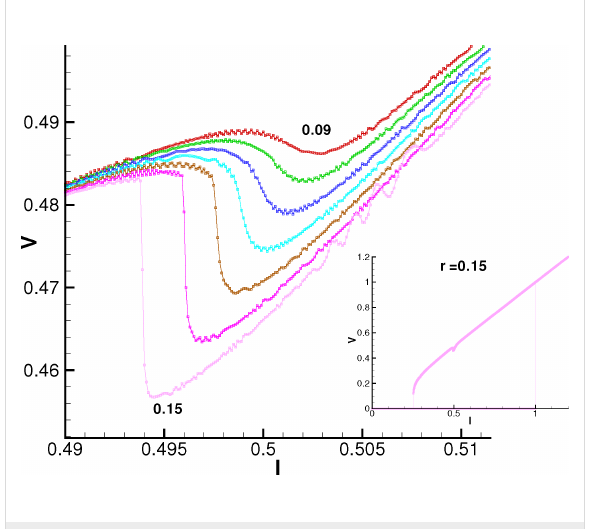
Figure 6: Enlarged parts of the I – V curves, in the resonance region at different values of the SOC parameter r , at α = 0.01 and G = 0.05. The numbers indicate the increase of r from 0.09 to 0.15 with an increment of 0.01. The inset shows the total I – V characteristics ar r =